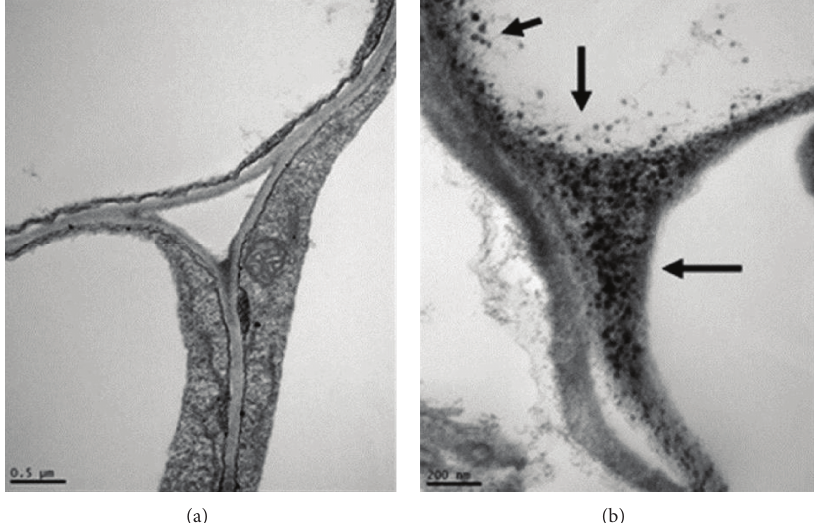
Figure 11: Transmission electron microscopy images of Buckwheat (Fagopyrum esculentum) root surface under control (a) and treatment (b) with ZnO nanoparticles (1,000 mgL −1 ) [31].